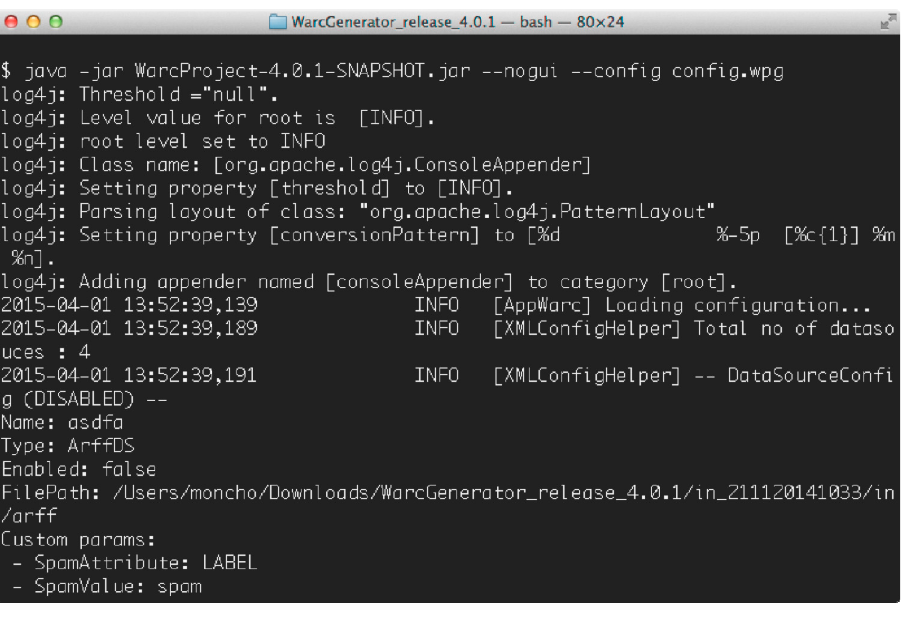
Figure 8. WARCProcessor running in batch mode.